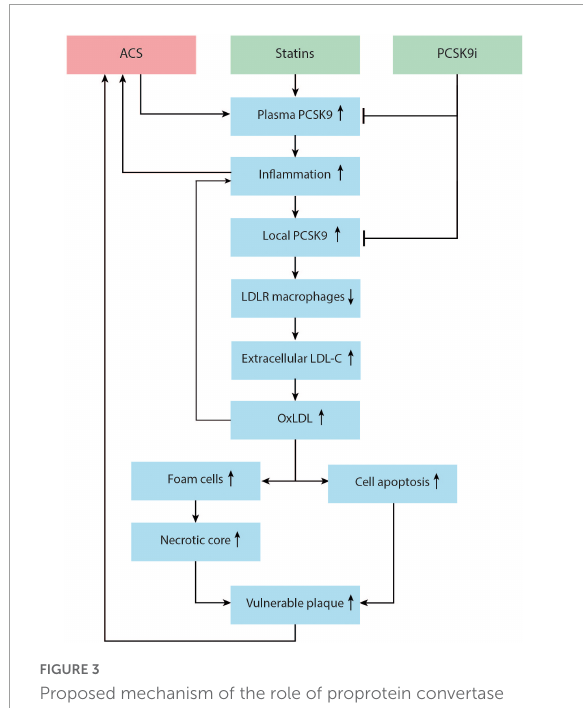
FIGURE3 Proposed mechanism of the role of proprotein convertase subtilisin/kexin type 9 (PCSK9) enzyme in the promotion of vulnerable plaque and recurrent acute coronary syndrome (ACS). ACS and statin therapy can both upregulate plasma PCSK9. Plasma PCSK9 can promote inflammation, increasing the risk for recurrent ACS. Local inflammation in the vessel wall can upregulate local PCSK9 production by smooth muscle cells (SMCs). Local PCSK9 can downregulate macrophage low density lipoprotein-cholesterol (LDL-C) receptors, decreasing LDL-C uptake and increasing the pool of extracellular lipid. This extracellular LDL-C is transformed to oxLDL, which activates pro-inflammatory genes and pro-inflammatory cytokine production, and induces SMC and endothelial cell apoptosis. Macrophages take up oxLDL via scavenger receptors, thus promoting foam cell formation and necrotic core formation. This process might increase vulnerable plaque and risk for recurrent ACS. PCSK9 inhibitors lower plasma PCSK9 and might also lower local PCSK9 in the vessel wall, inhibiting this